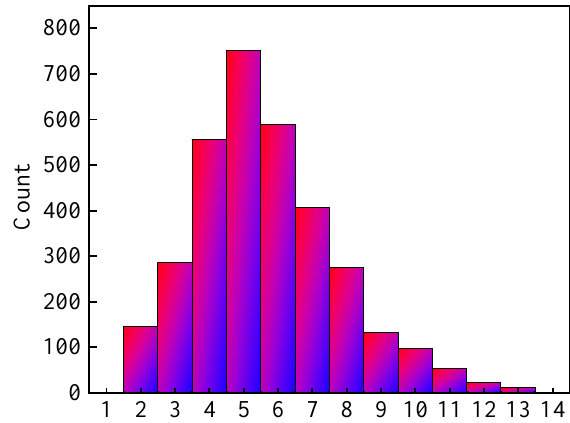
Figure 13. Bubble residence time.